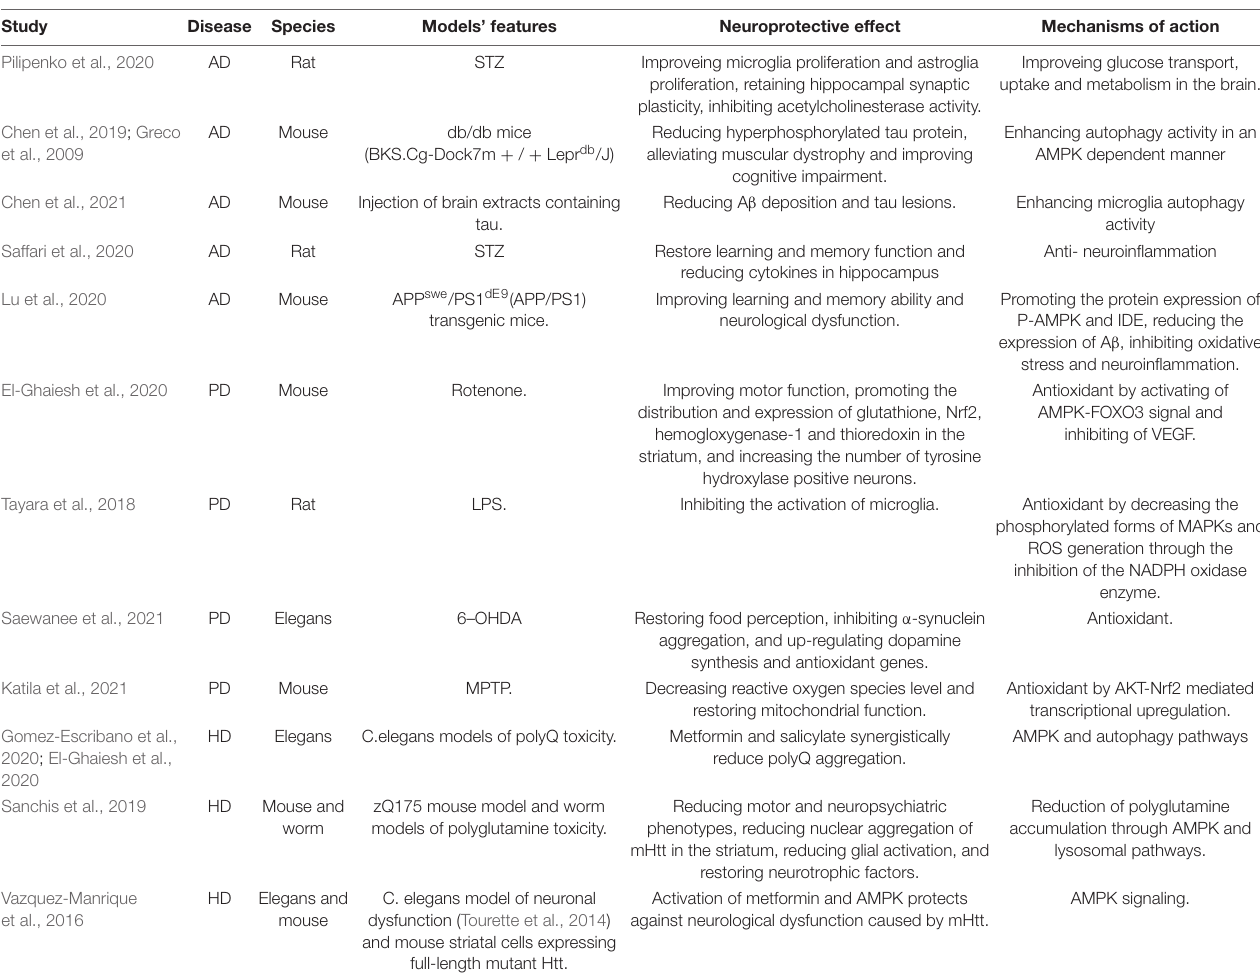
TABLE 1 | Effects of metformin on neurodegenerative disease